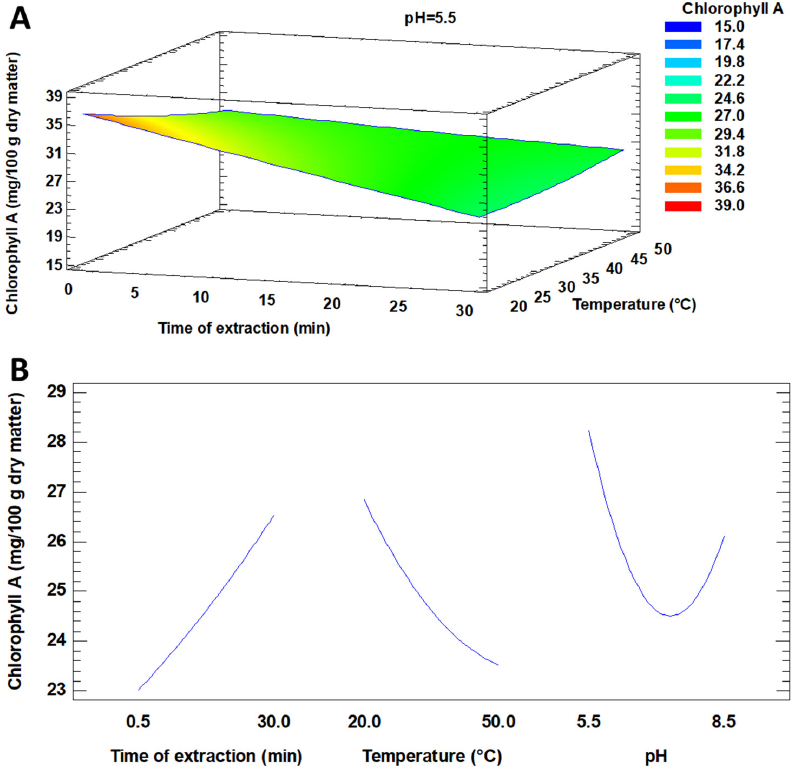
Figure 3 . Influence of the different extraction conditions ( A ) and main effects chart for these condi- tions ( B ) on chlorophyll A’s recovery yield (mg/100 g dry matter). The least relevant factor (highest p-value) has been set at its optimal value.